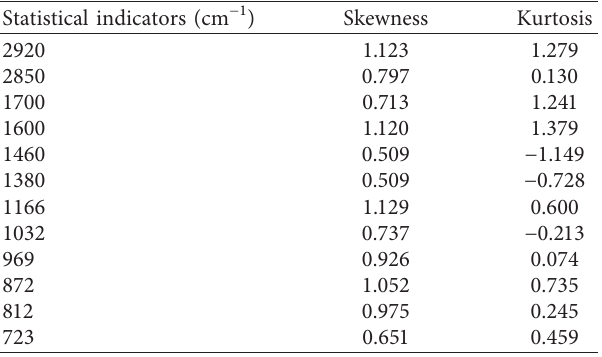
Table 3: The skewness-kurtosis test of the 12